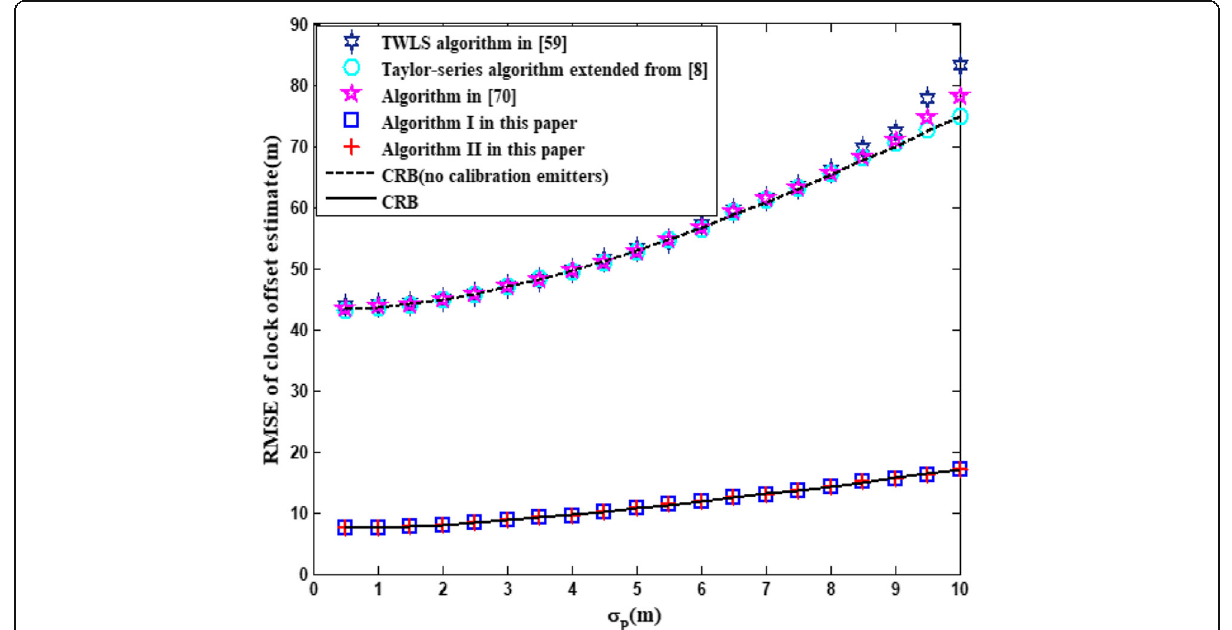
Fig. 11 RMSE of clock offset estimate versus σ P